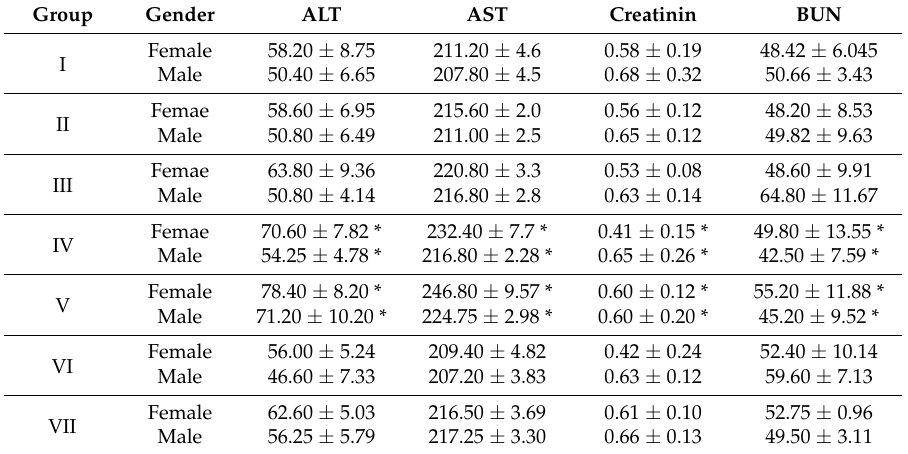
Table 3. Effect of P. fel-terrae leaf extract on biochemistry parameters (Mean ±